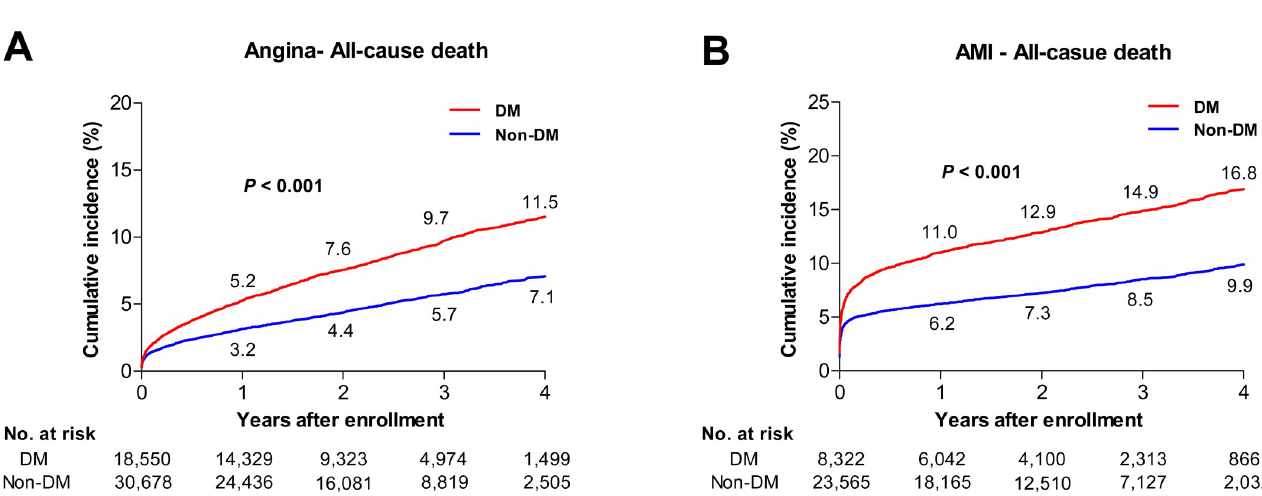
Fig 2. Cumulative incidence rates for all-cause deaths in the study population. Cumulative incidence rates for (A) all-cause death in patients with angina and (B) in those with acute myocardial infarction. The numbers in each figure represent the cumulative incidence rates at each time point. AMI = acute myocardial